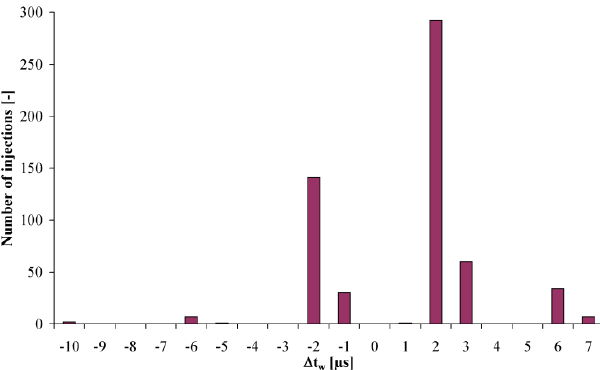
Fig. 14. Diagram of discrepancy (absolute error) of injection time obtained during verification